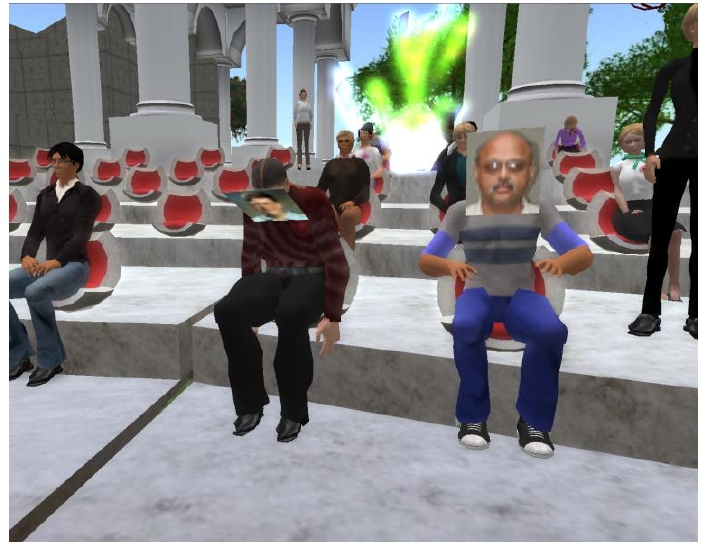
Figure 3. User applying a photo “mask” to his avatar in lieu of